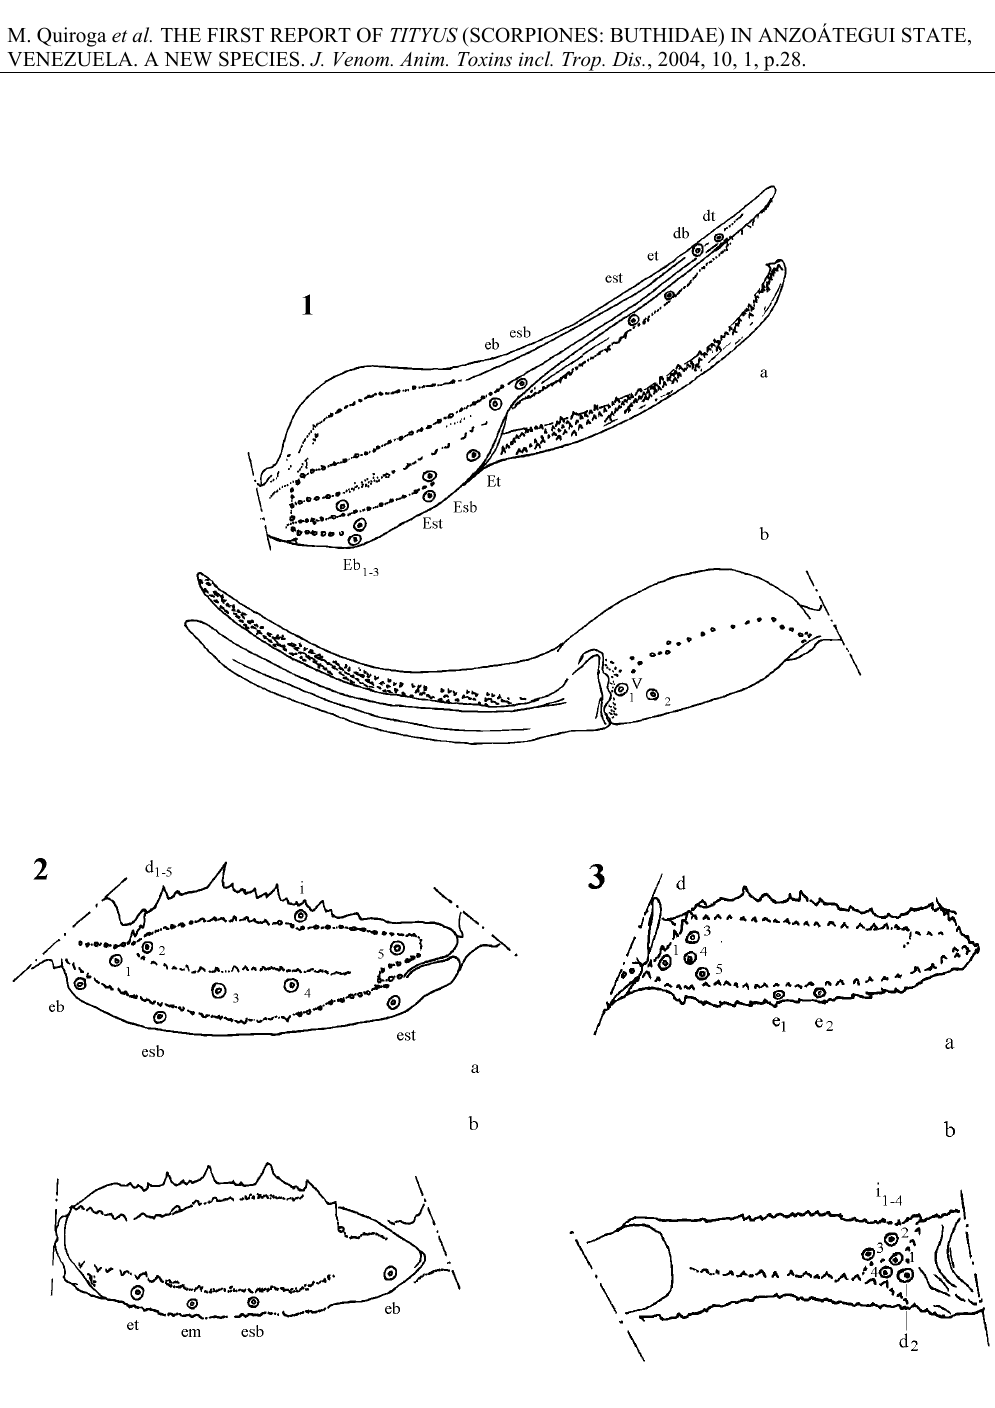
Figure 6 . Tityus gonzalespongai n. sp. Female. 1- Right chela. a. Dorsal view. b. Ventral view. 2- Right tibia. a. Dorsal view. b. Ventral view. 3- Right femur. a. Dorsal view. b. Internal